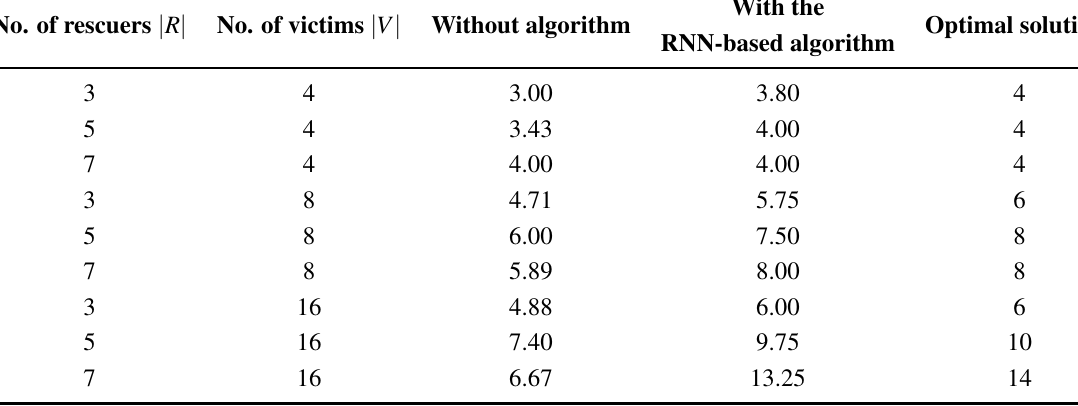
Table 3. Number of evacuees saved by